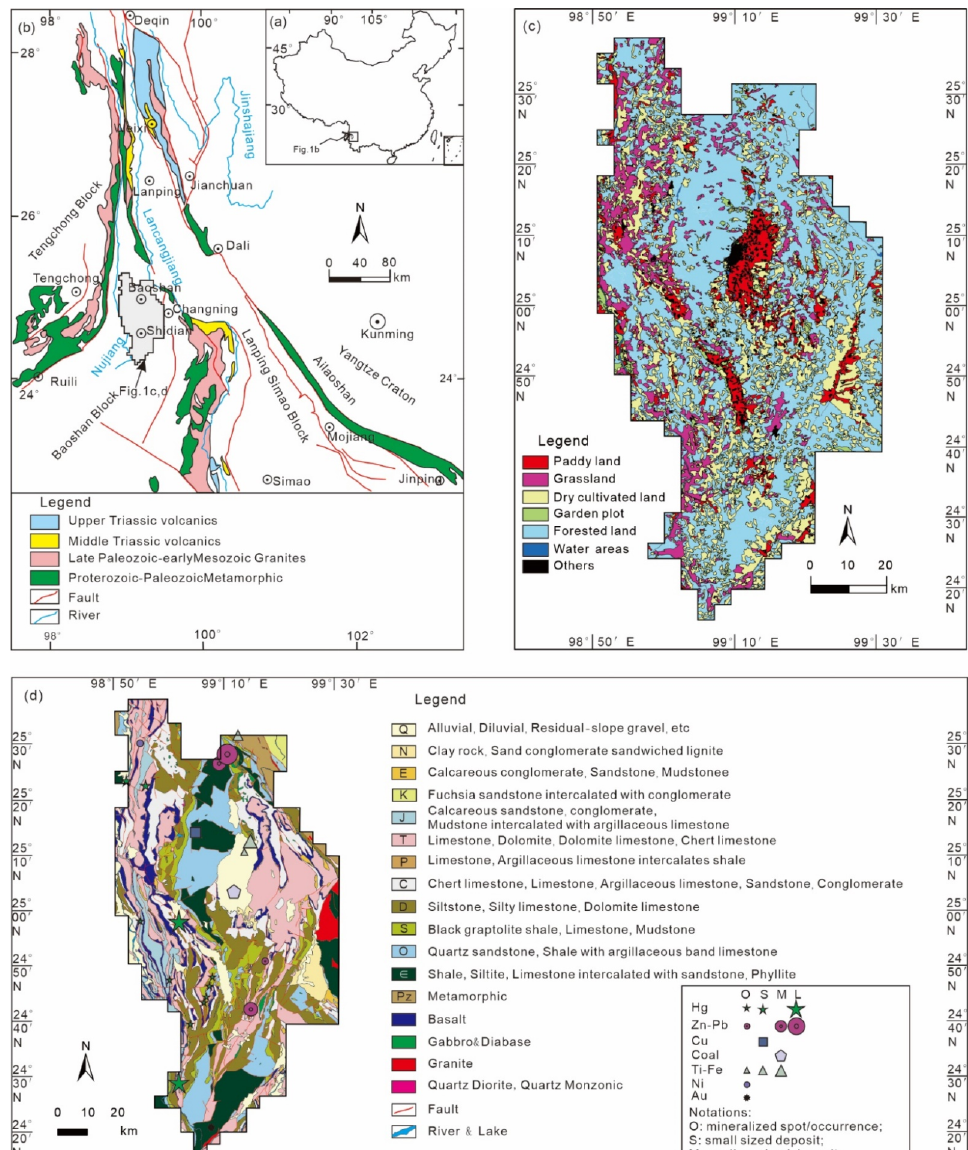
Figure 1. General situation of the study area, reproduced from [54,55], with permission from Elsevier, 2022; ( a ) location of the study area in China; ( b ) simplified tectonic map of Yunnan Sanjiang area; ( c ) simplified land-use map of the study area; ( d ) simplified geological and mineral deposits map of the study